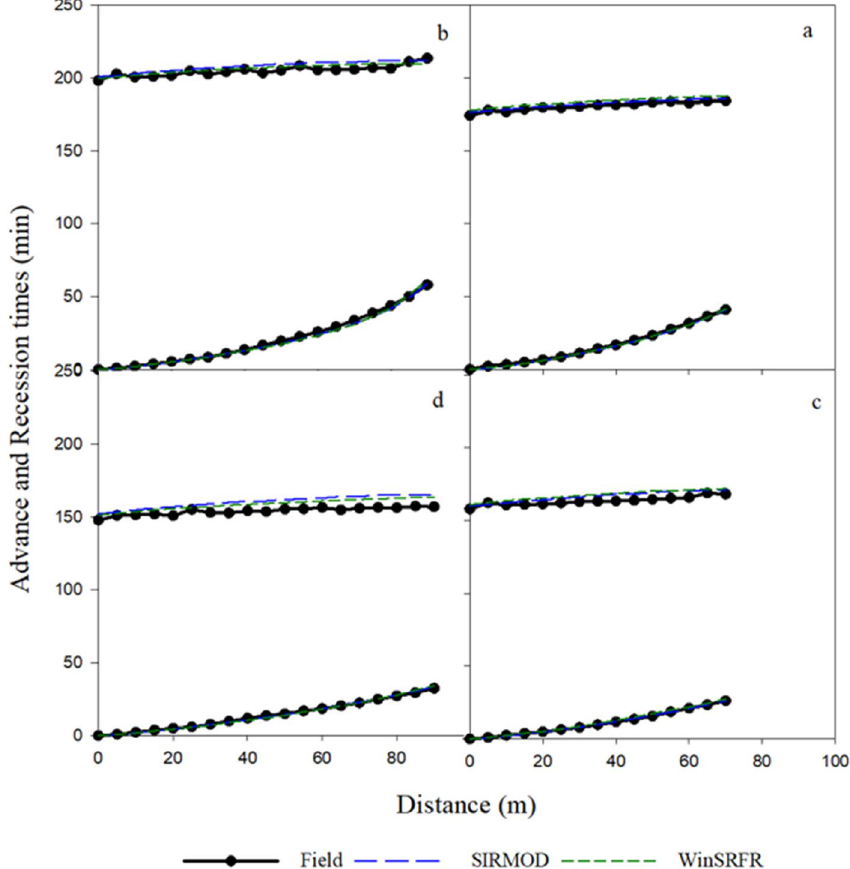
Figure 3. Comparison of the measured and simulated advance-recession times under continuous irrigation ( a . Q